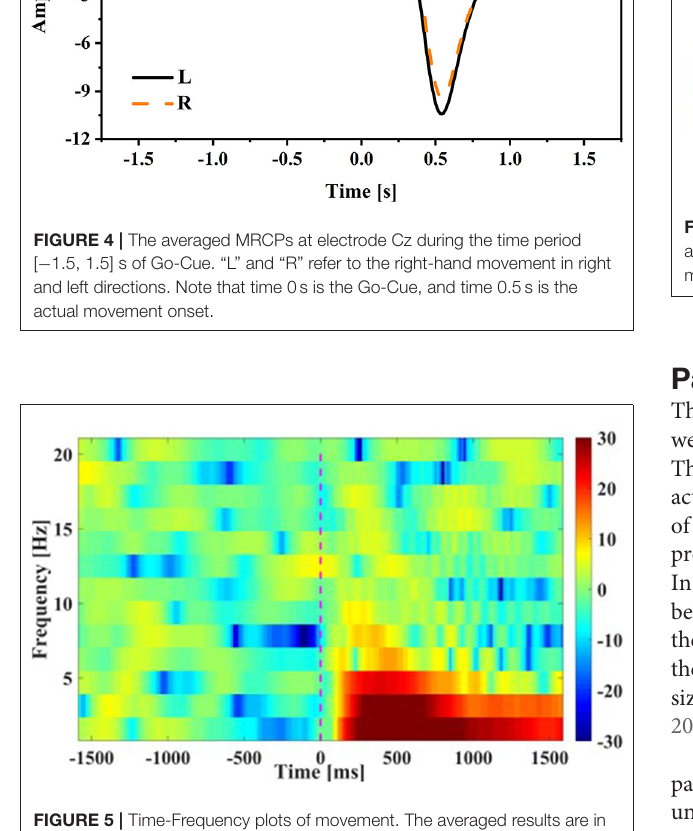
FIGURE 5 | Time-Frequency plots of movement. The averaged results are in frequencies [0 16] Hz at Cz channel from − 1.5 to 1.5s of the movement cue onset. Note that time 0s is the Go-Cue, which indicates the movement execution, and time 0.5s is the actual movement onset.